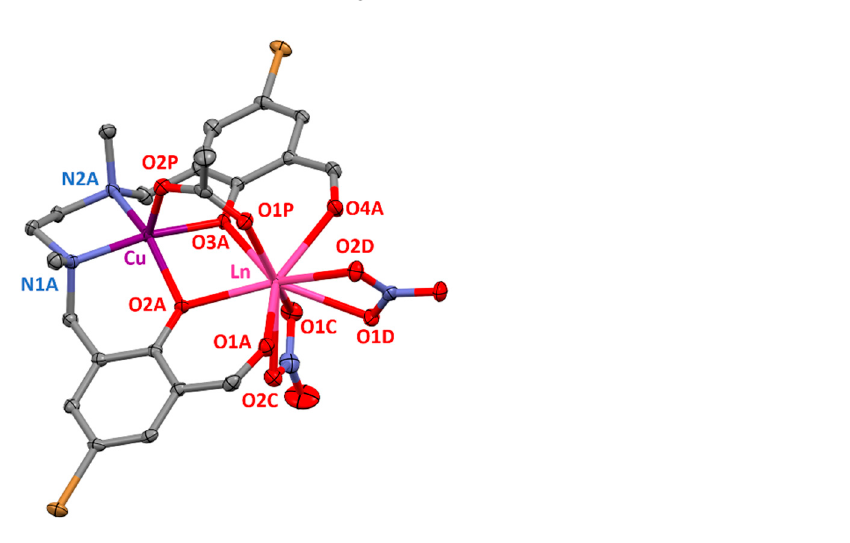
Figure 1. Perspective view of the molecular structure of 1–4 . Crystallization solvent molecules and hydrogen atoms are omitted for the sake of clarity. Colour code: N = blue, O = red, C = grey, Br = brown, Cu = purple, Ln = pink.